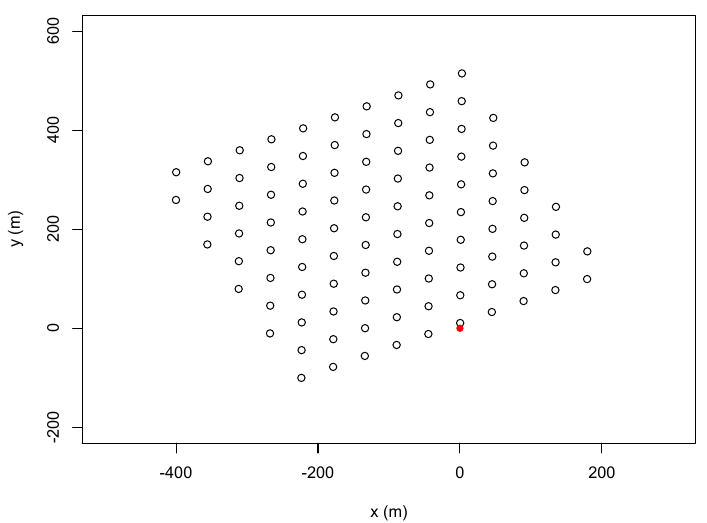
Figure 1. Experimental set − up: the open circles indicate the probe positions and the red dot the source position. x − axis is directed from west to east, y − axis is directed from south to